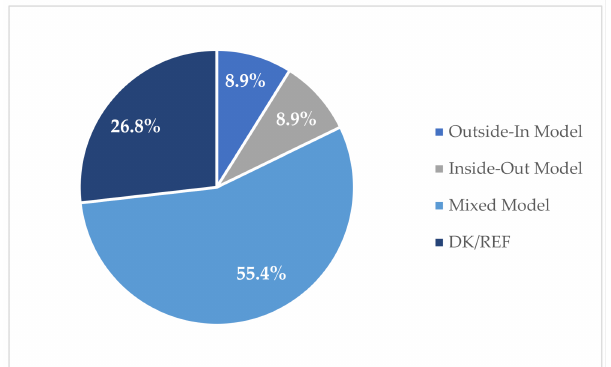
Figure 8. Most likely adoption open innovation approaches among surveyed